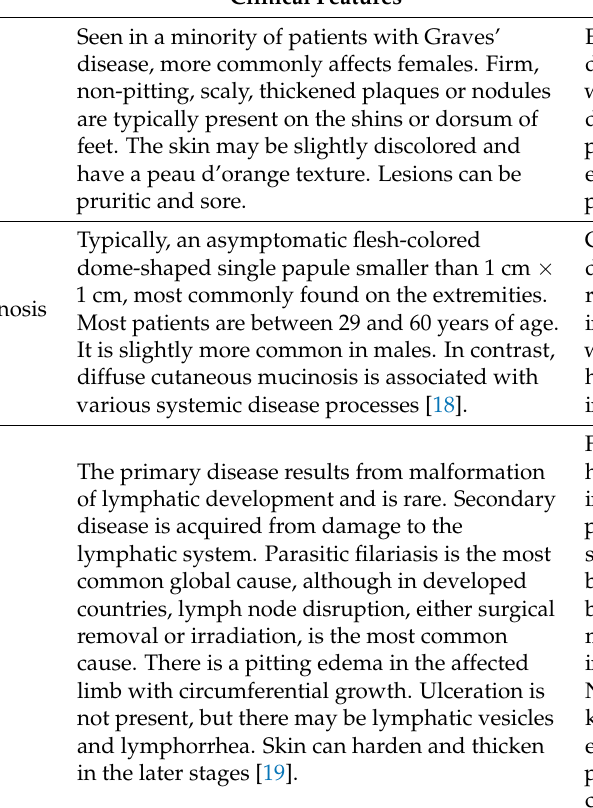
Table 1. Characteristic clinical and histological features of localized pretibial lesions.